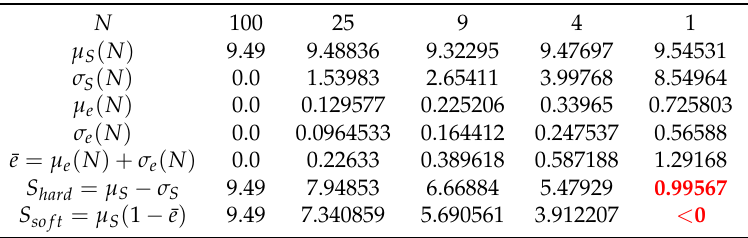
Table 5. Results for the average trap counts obtained for the beetle population on a sequence of coarse grids from Data Set II in Figure 5. The mean value µ S ( N ) and the standard deviation σ S ( N ) are computed for the average trap count S c on a sequence of quasi-regular grids with number N of sampling locations. For any realisation of the average trap count the error (2) is computed. Given K realisations of error (2), the mean evaluation error µ e ( N ) , the standard deviation σ e ( N ) of the evaluation error, and the upper error bound µ e ( N ) + σ e ( N ) are computed for each N in the table. The estimated values of the average trap count that falls below the hypothetical management point (conservation target) of S ∗ = 2 beetles per trap are shown in red. N